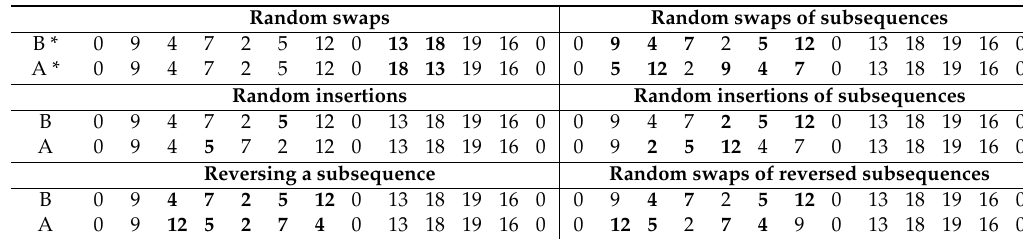
Table 1. Applied neighborhood operators